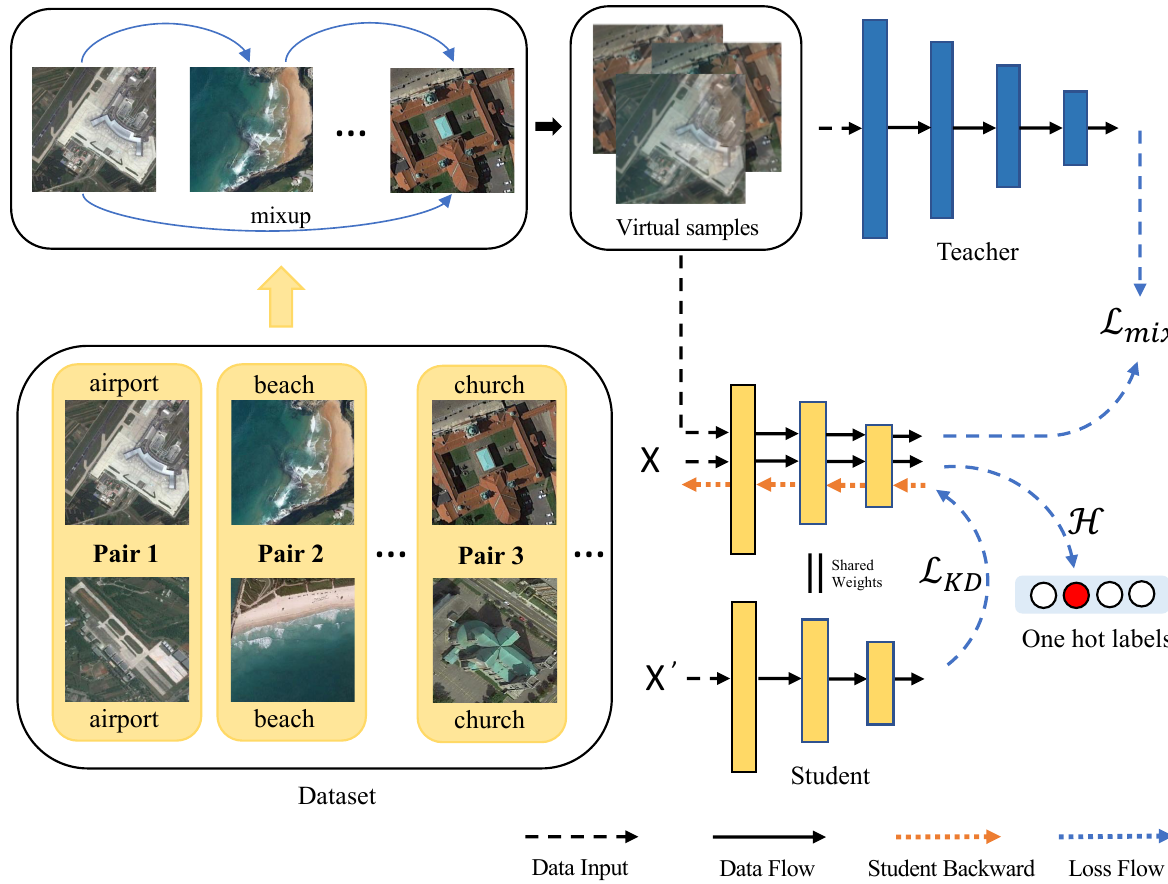
Figure 2. The overall framework for our pair-wise similarity knowledge